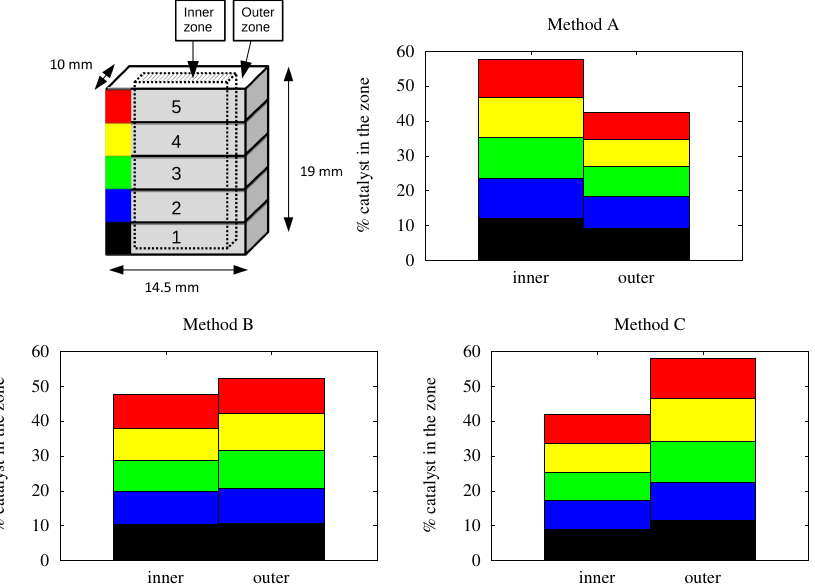
Figure 5. Zones of thickness measurement and distribution of the Al 3 methods in the parallelepipedic Al